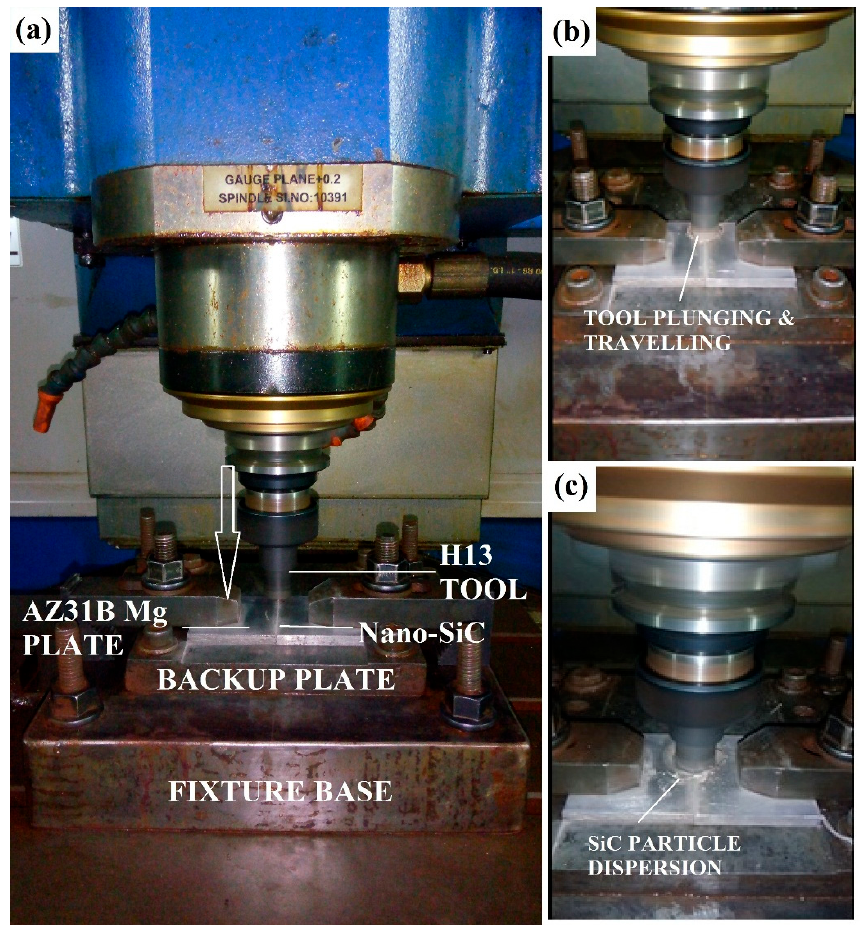
Table 3. Fraction stir welding (FSW) process parameters used in this study.